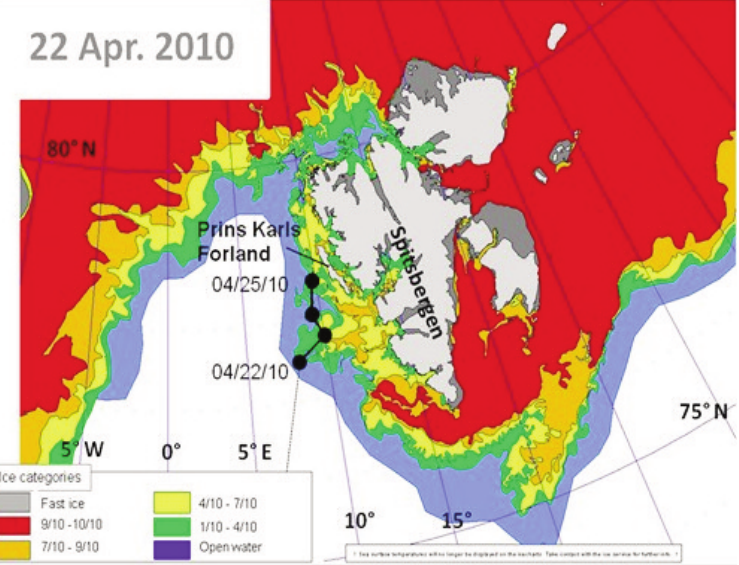
Fig: 5 . Ice conditions around the Svalbard archipelago on 22 April 2010 with the last locations (22–25 April 2010) received from an adult male Atlantic walrus tagged in the Faroe Islands. Ice source: Norwegian Sea Ice Service (Tromsø, Norway; www.met.no). Sea ice concentration cate- gories are given in